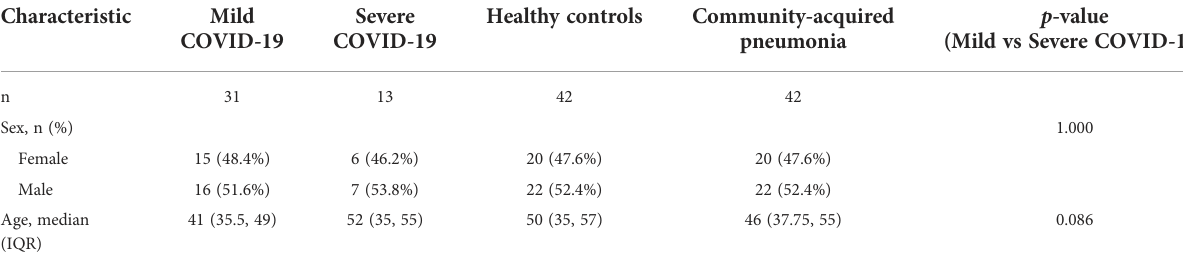
TABLE 1 The baseline clinical information of both